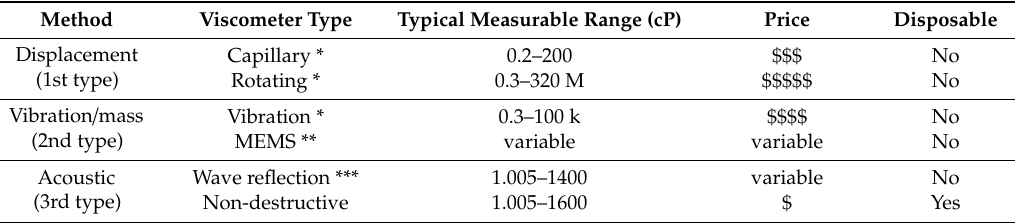
Table 1. Comparison of our probe with the existing type of devices.